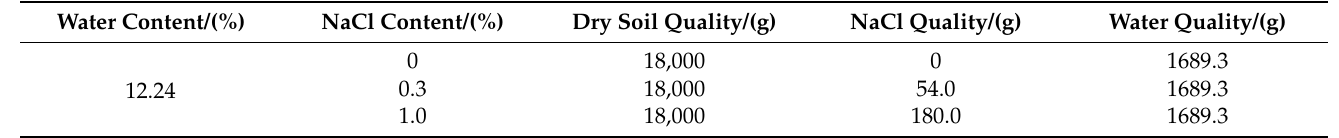
Table 3. Proportion of soil samples with different NaCl content.